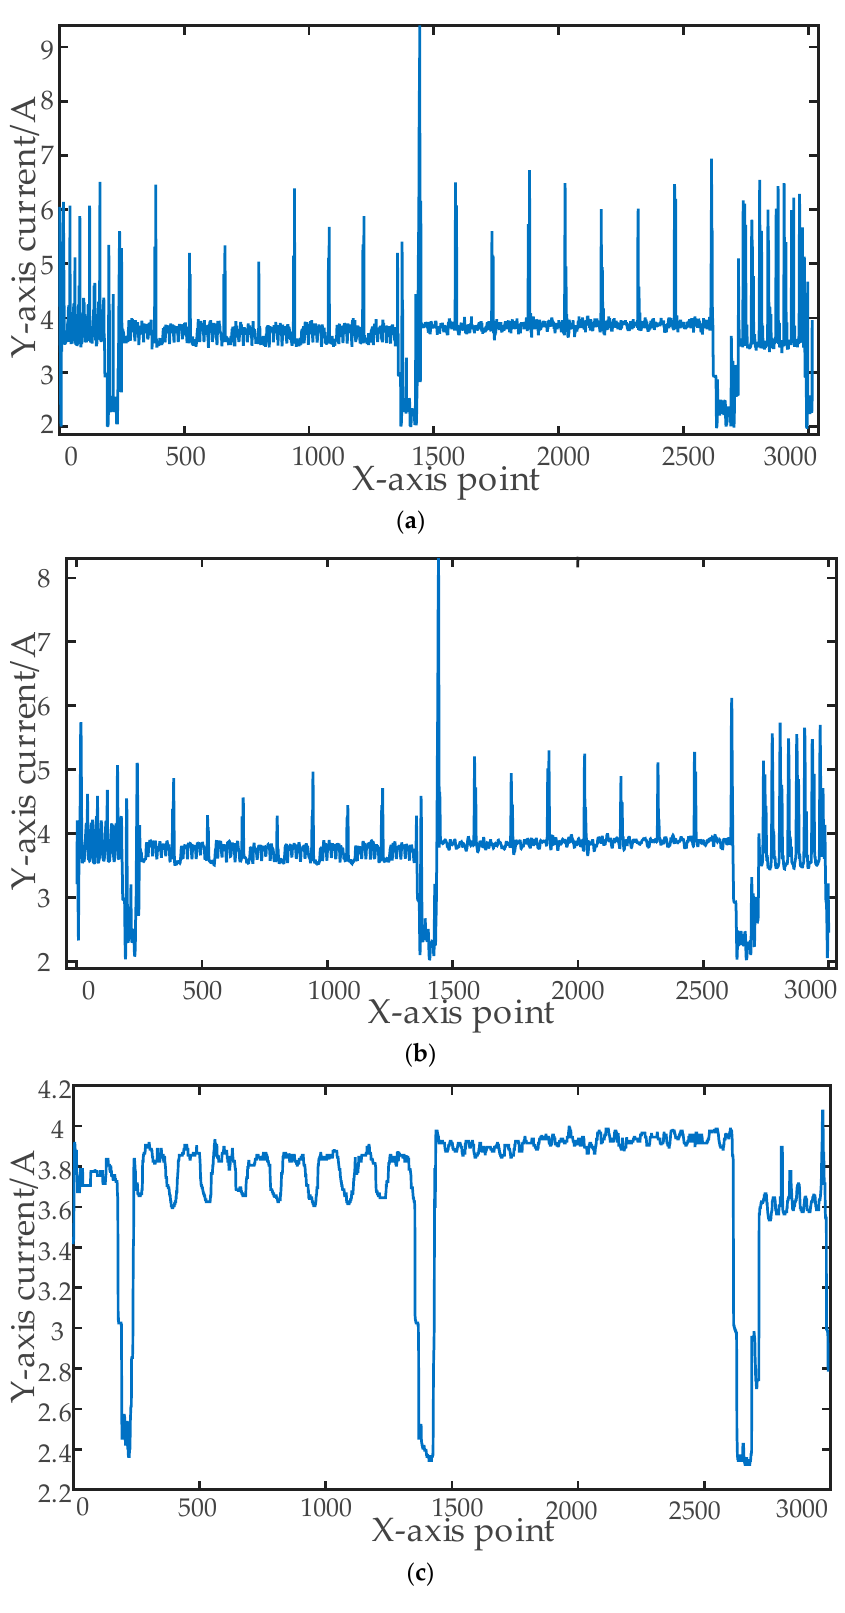
Figure 6. Curve comparison schematic of ( a ) Raw data curve; ( b ) Gaussian filtering curve; ( c ) Median filtering curve. Table 3. Feature point vectors.